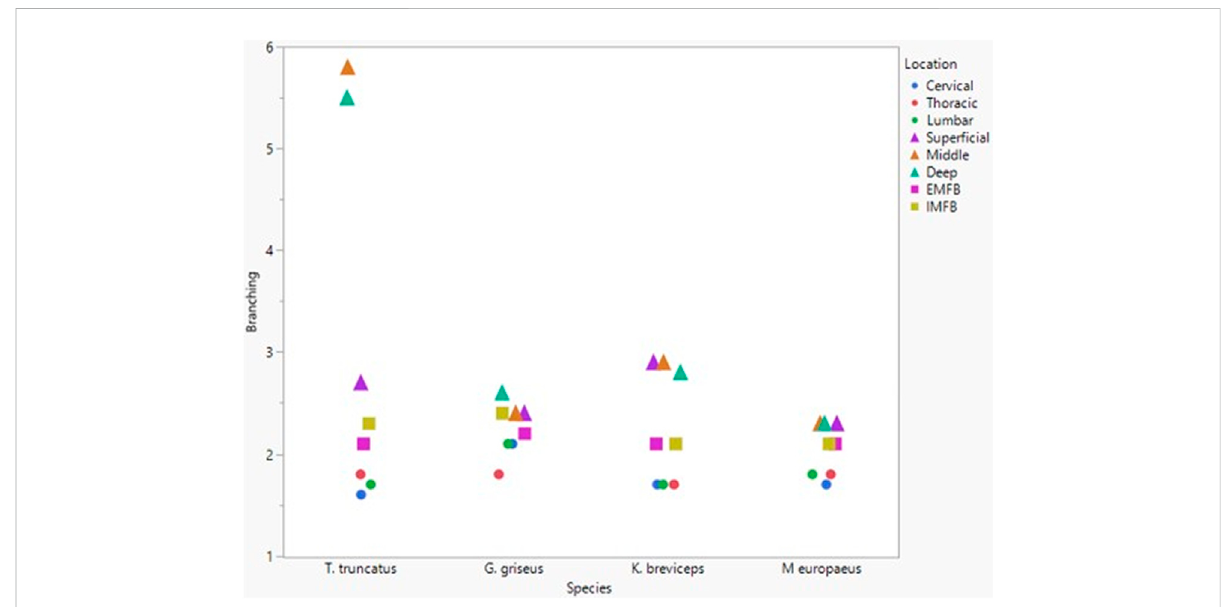
FIGURE 8 Mean microvascular branching between odontocete blubber layers (super fi cial, middle, deep) (McClelland et al., 2012; triangle), acoustic fats (intramandibular fat bodies — IMFB and extramandibular fat bodies — EMFB) (Gabler et al., 2018; square), and length of spinal cord (cervical, thoracic, lumbar) (circle) tissues.